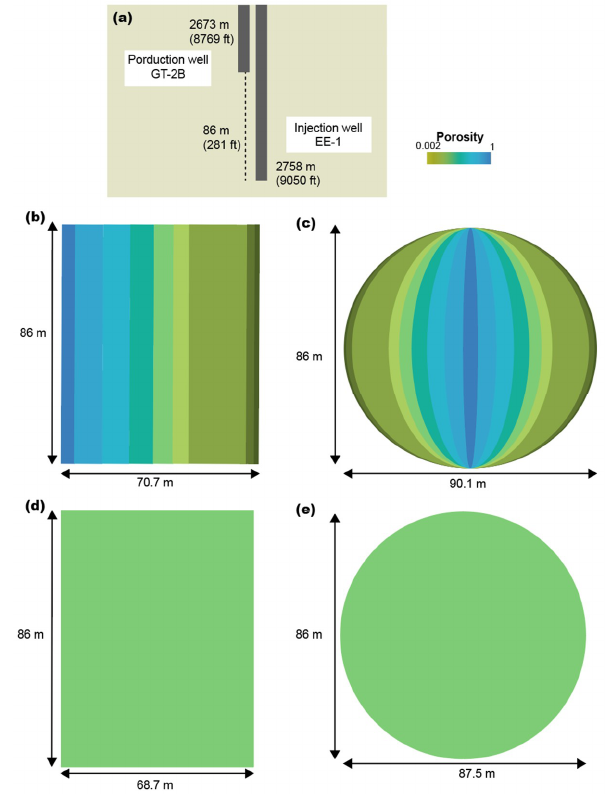
Figure 11. Curve fitting to temperature decline curve from Fenton Hill Phase I reservoir.